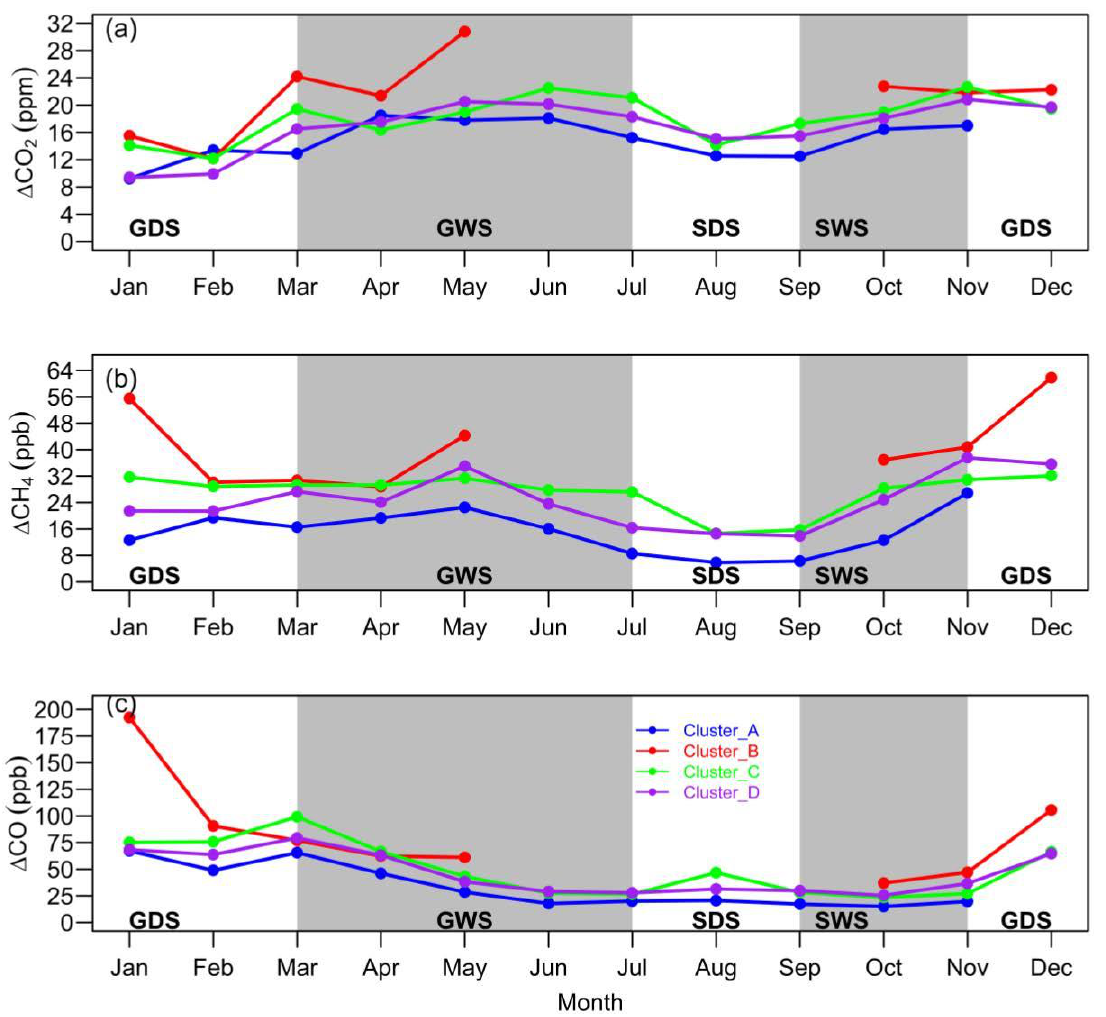
Figure 12. Annual cycles of excess concentrations of ( a ) CO 2 , ( b ) CH 4 , and ( c ) CO associated with each cluster.